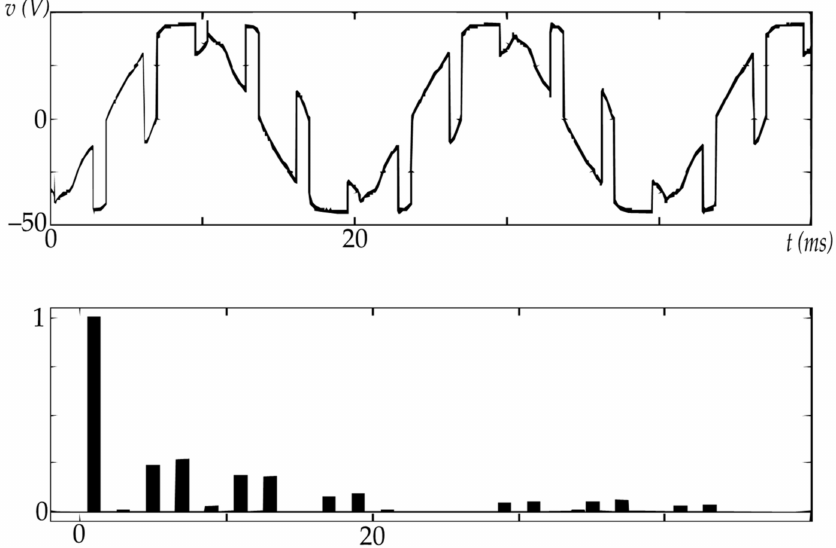
Figure 10. The voltage output of the 6 × 6 MMC working under the “two closest” approach to the control procedure with 10 ◦ phase shift versus the input voltage waveform and its harmonic